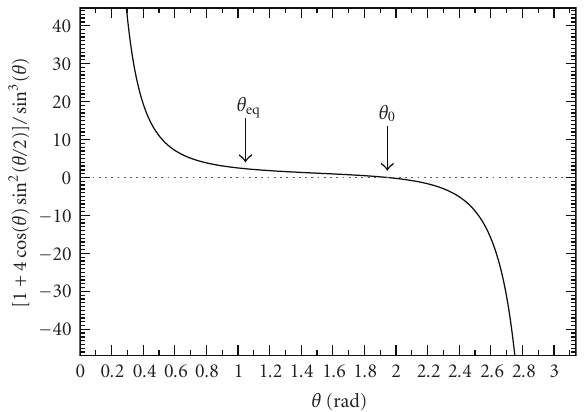
Figure 18: Angular dependency of the isosceles bispectrum as a function of the angle θ in between the wavevectors k 1 and k 2 . The particular values θ eq = π/ 3 corresponds to the equilateral configuration and θ 0 makes the bispectrum vanishing. Notice the amplification for flat triangle configurations at θ → 0 (squeezed) and θ → π